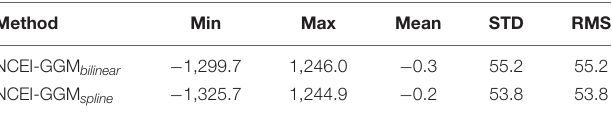
TABLE 6 | Statistics results of difference between NCEI data and bathymetry calculated by bilinear interpolation and cubic spline interpolation in area A (unit: